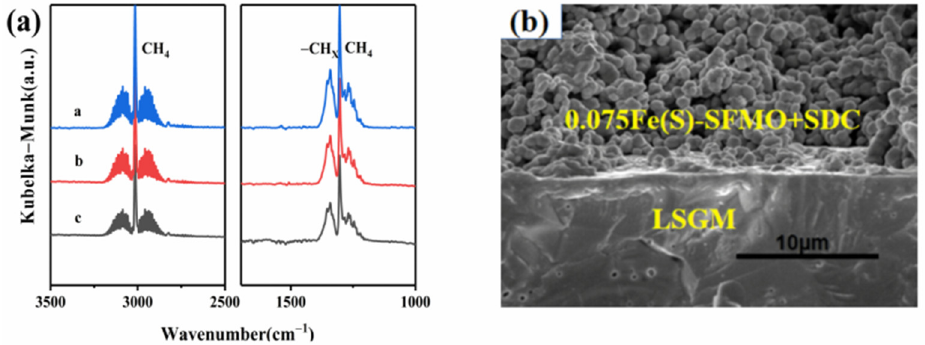
Figure 6. Methane adsorption and the cell morphology. ( a ) FT − IR spectroscopy of CH 4 for electrode powders (a: 0.075Fe(S)-SFMO, b: 0.075Fe(I)-SFMO, c: SFMO); ( b ) cross − sectional SEM results for 0.075Fe(S)-SFMO-SDC before test.